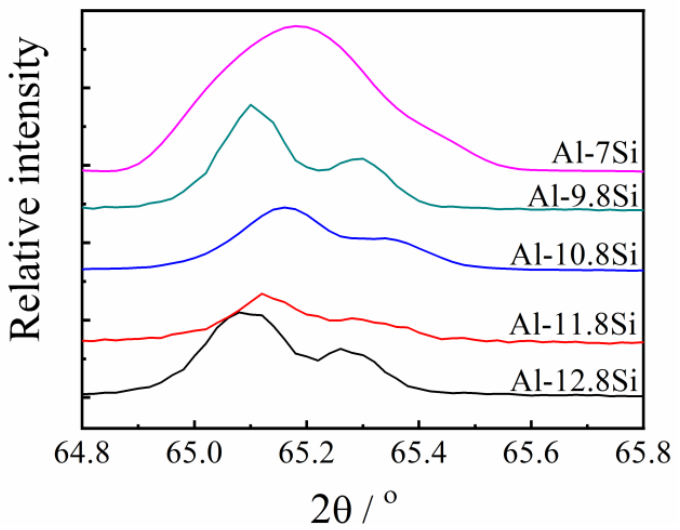
Figure 3. X-ray diffraction spectra of the Al-Si alloys with the stated Si contents.